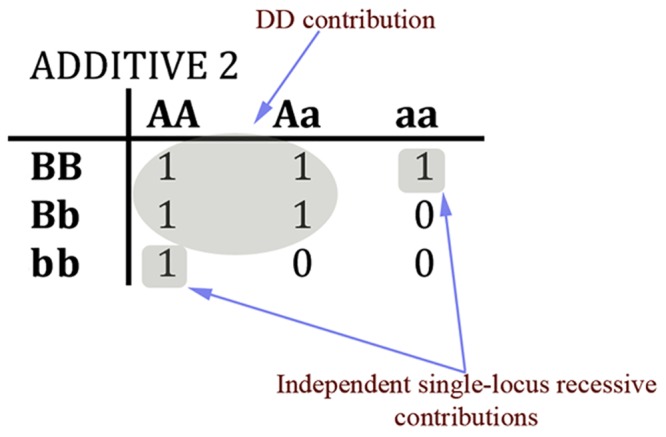
Diagrammatic representation of the ADD2 model, highlighting the DD contribution and the two single-locus recessive contributions.